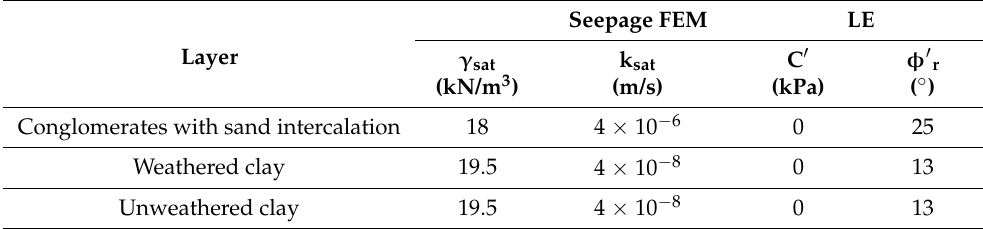
Seepage FEM LE γ sat k sat C (cid:48) (kN/m 3 ) (m/s) ( ◦ )